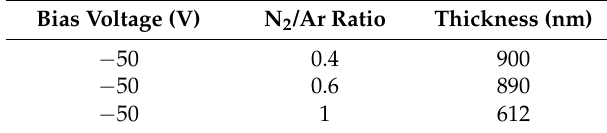
Table 3. The thickness of NbN coatings as a function of N 2 /Ar ratio.